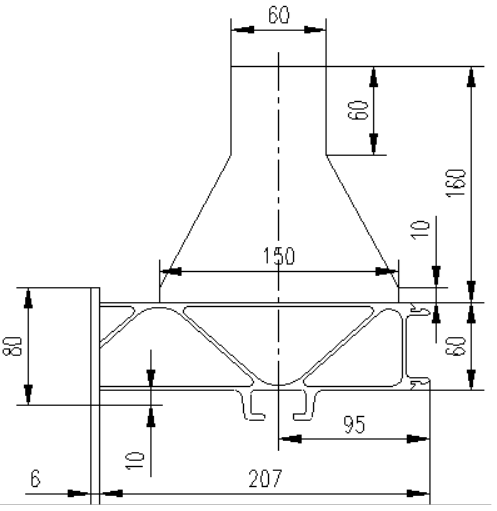
Figure 1. Real structures and test structural component. ( a ) Real structures; ( b ) test structural component cut from real structures.